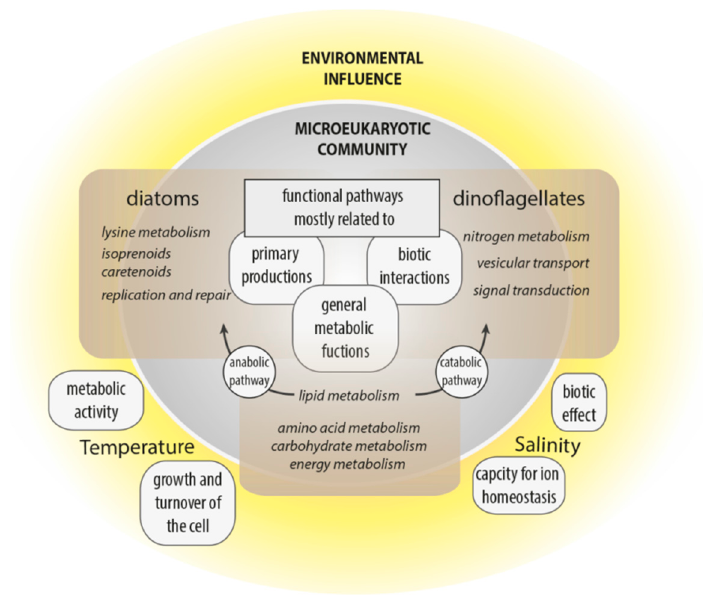
Figure 6. Summary of the main influences of temperature and salinity on the microeukaryotic community, and main functional pathways correlated with diatom or dinoflagellate abundance.